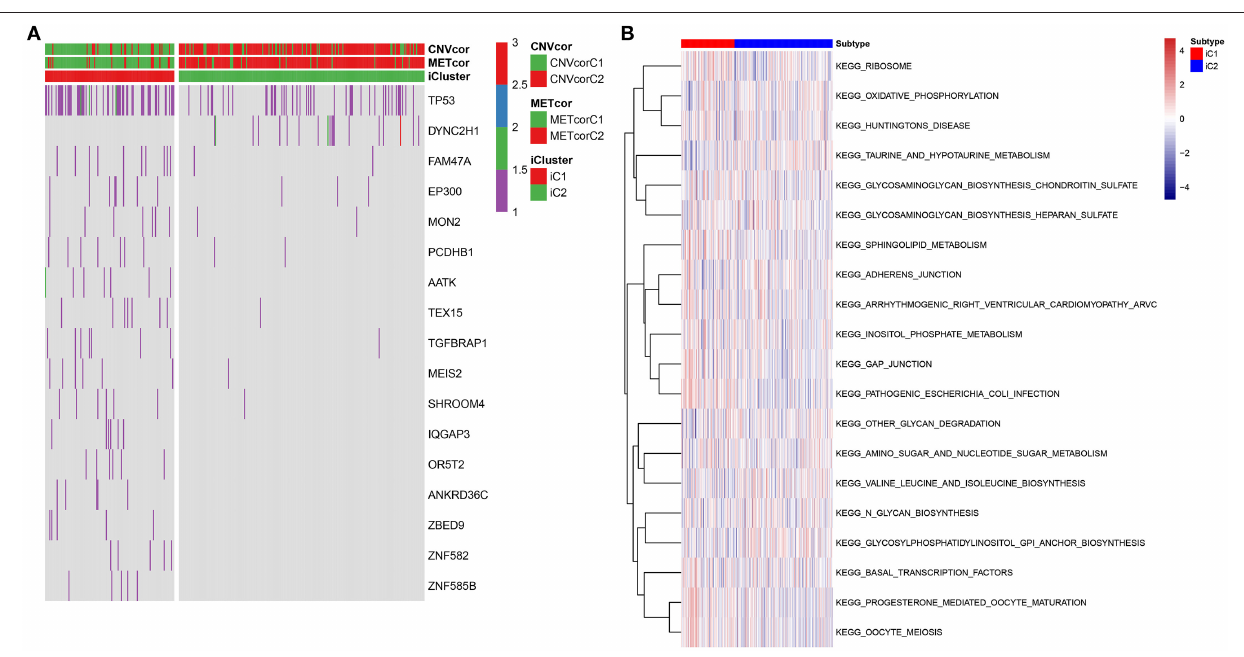
FIGURE 7 | Genetic mutations and enriched pathways in two multi-omics molecular subtypes for liver cancer. (A) Differences in genes with single-nucleotide variant (SNV) in iC1 and iC2 multi-omics molecular subtype for liver cancer. Different colors express different numbers of mutations in a gene. (B) Differences in enriched signaling pathways between subtypes by GSVA method.